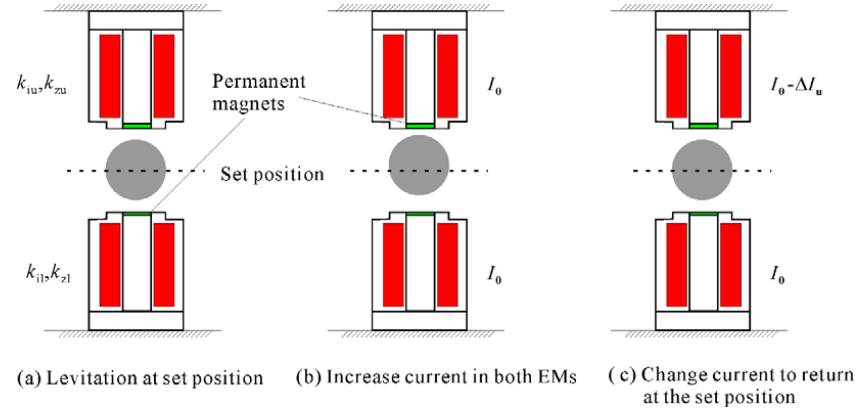
Figure 6. Finding the relationship between current ‐ force coefficients: ( a ) levitation at set position; ( b ) increase of current in both EMs; ( c ) reduction of current from EM u .